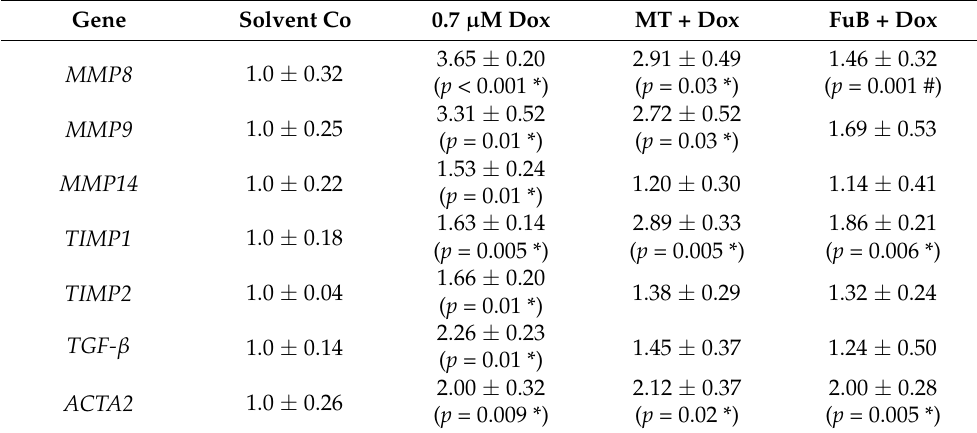
Table 4. Fibrosis related mRNA expression.